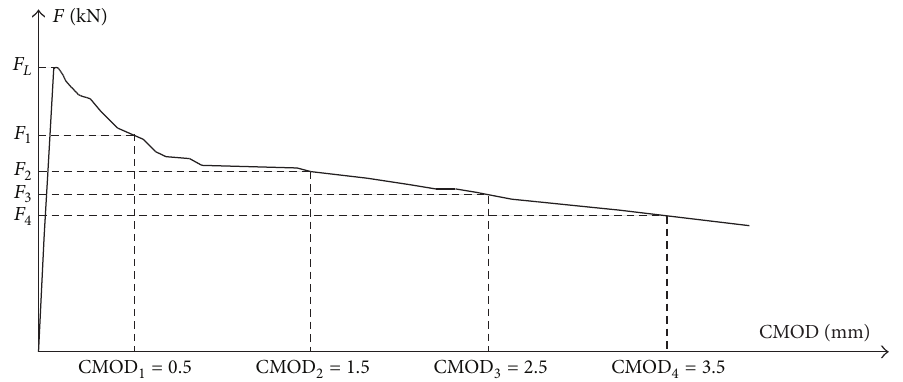
Figure 4: Typical load-CMOD curve from EN 14651 (2007).